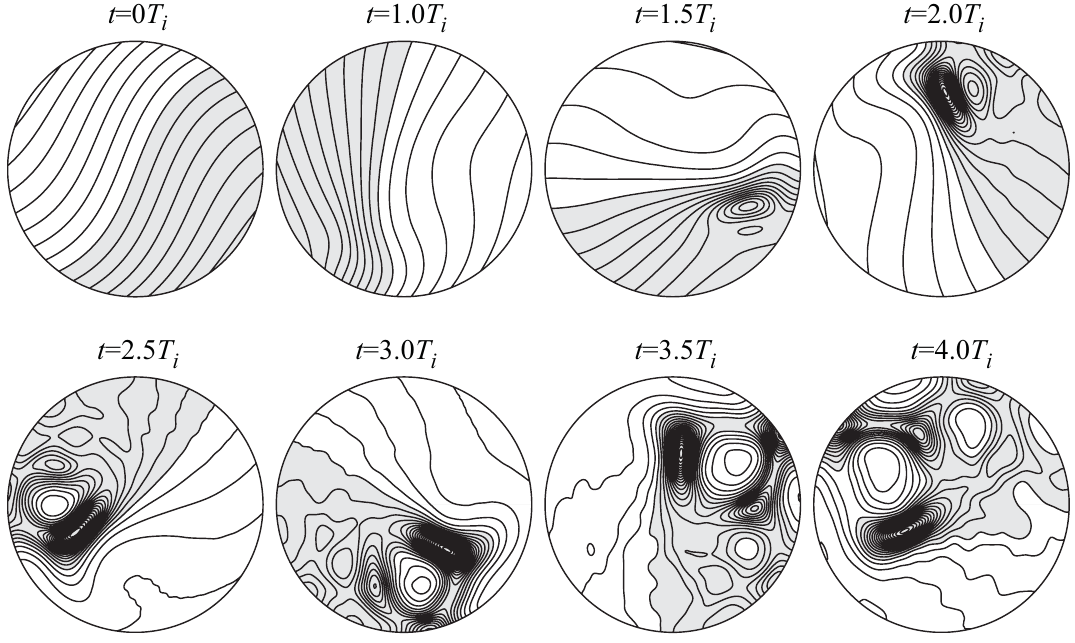
Fig. 11. Nonlinear evolution of the isopycinal amplitude Z of the first vertical mode. Contour level step is every 0.1 dimensionless unit from zero values, and shaded regions represent negative values. ( B = 2, W = 1 . 2, h 2 = 1, h 3 = 2).